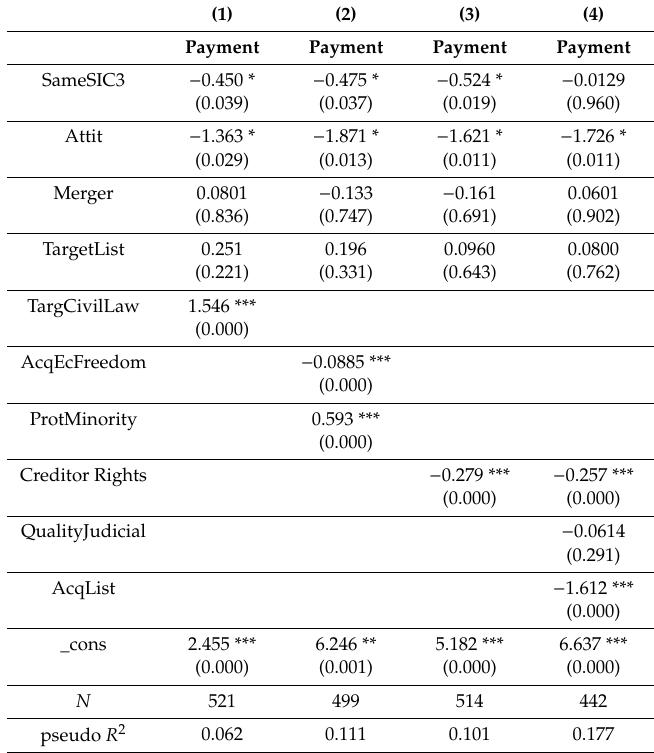
Table 4. Regressions on the determinants of the choice of the means of